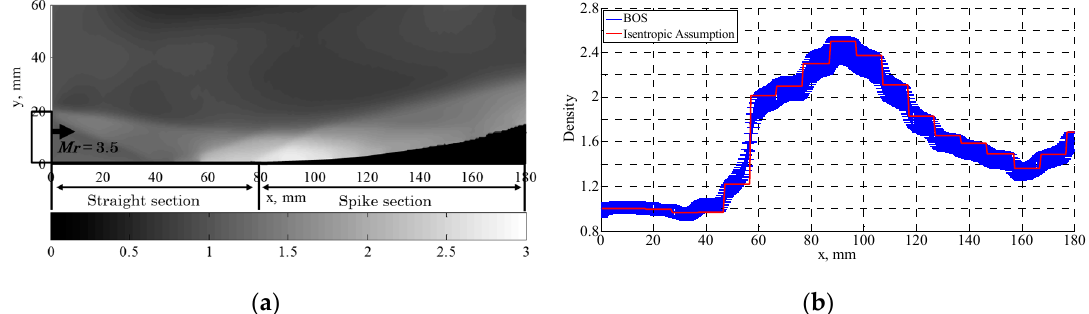
Figure 14. ( a ) Density field (flow direction left to right); and ( b ) wall density distribution when NPR = 35.0 without external flow.